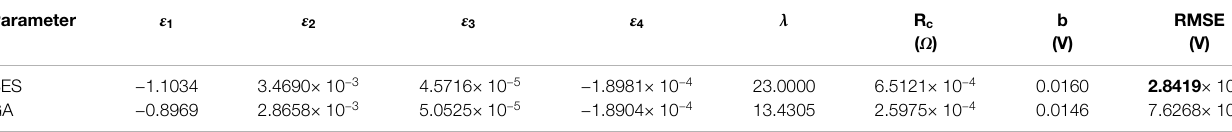
TABLE 3 | PEMFC parameter identi fi cation results. Parameter